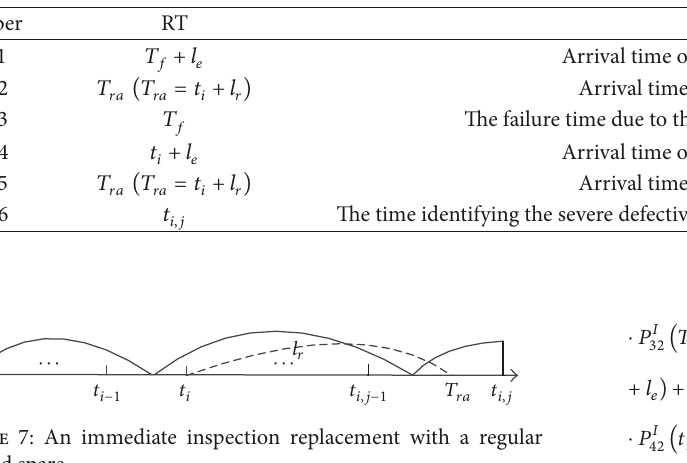
Table 3: Renewal time.